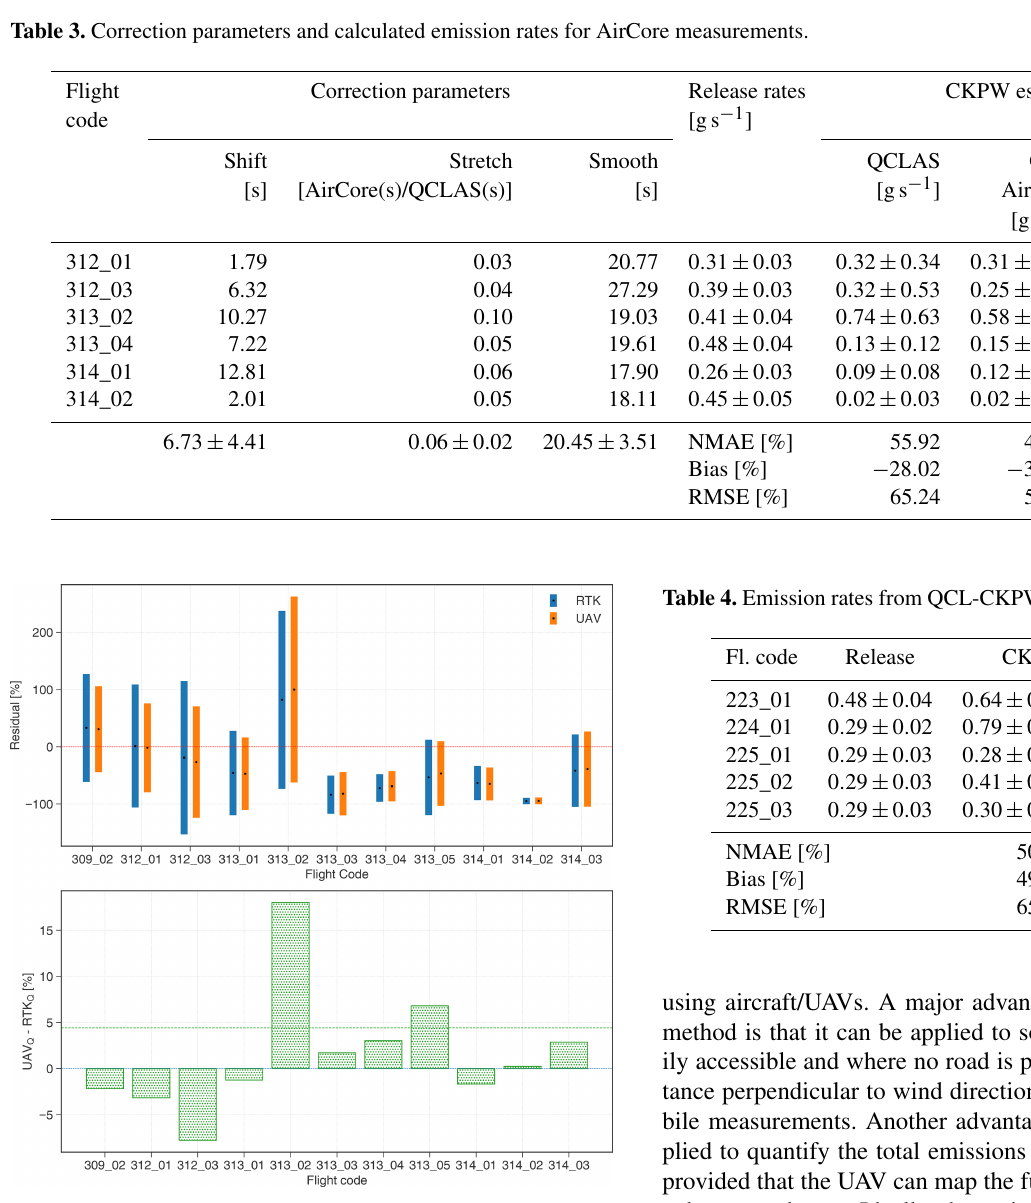
Figure 10. Difference in emission estimates using two different GPS altitudes. The dashed green line represents the absolute av- erage difference between the two estimates.